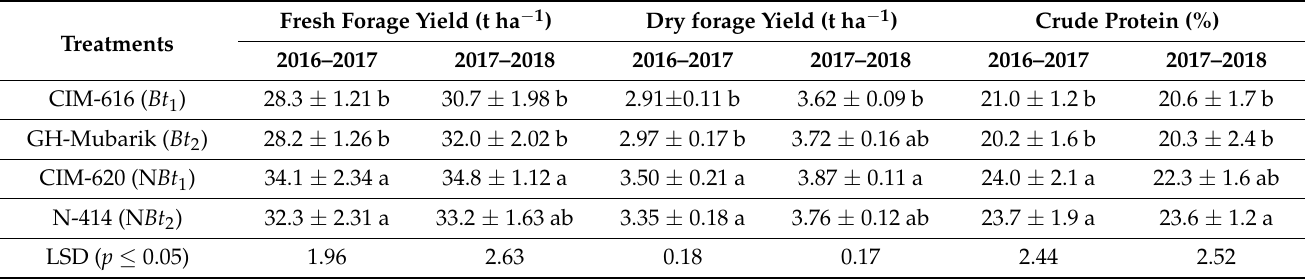
Table 8. The influence of various cotton varieties on yield-related traits of Egyptian